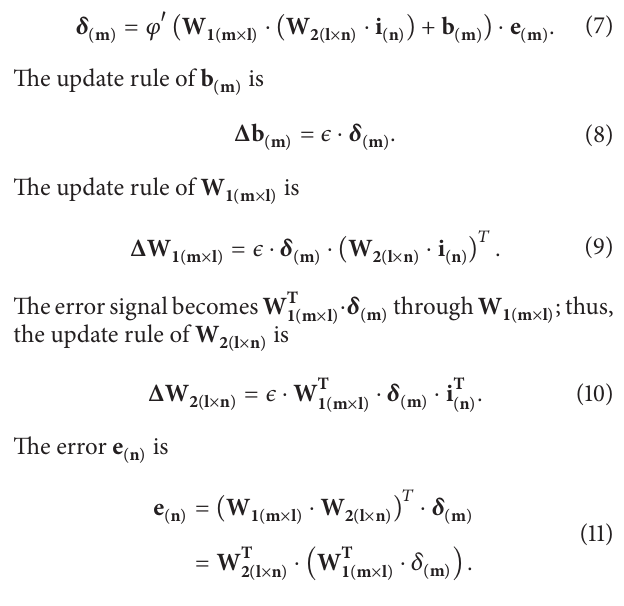
Algorithm 1 (the weight-matrix-restructuring-based BP algo- rithm).